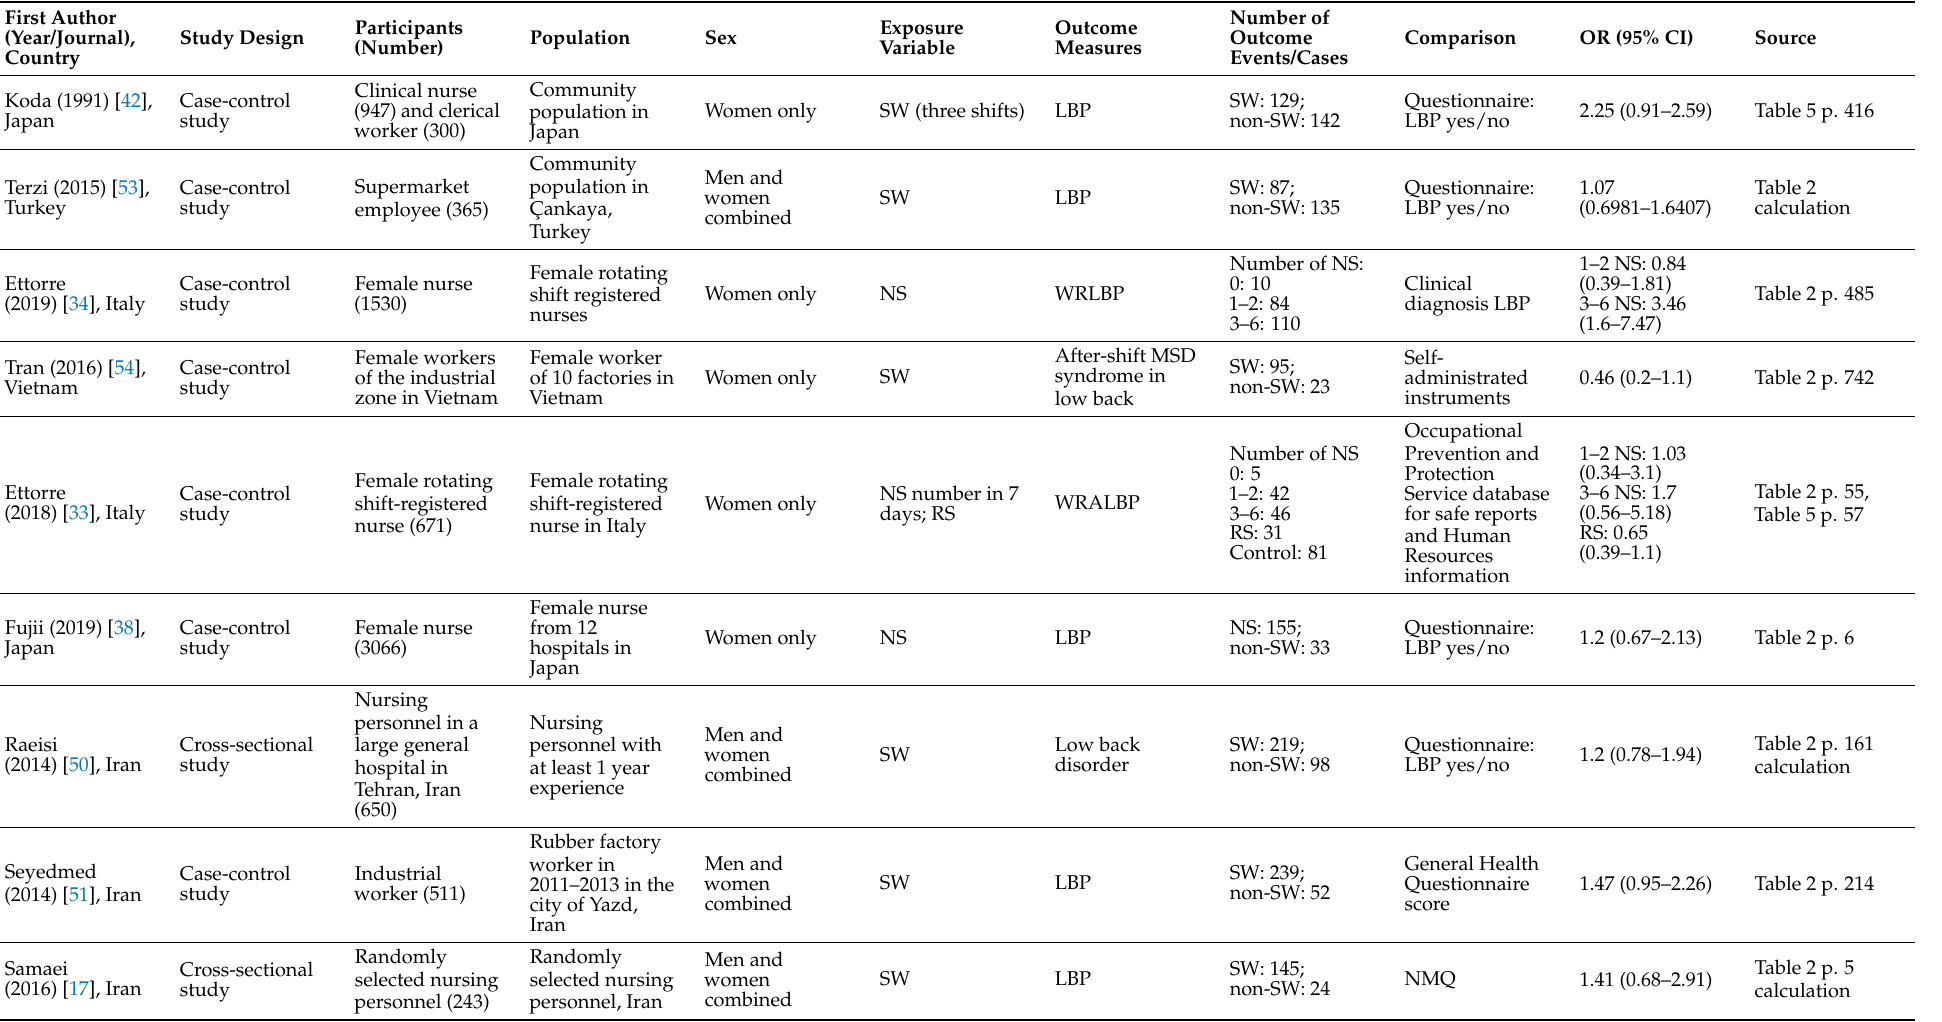
Table 1. Characteristics of studies included in the meta-analysis (N =